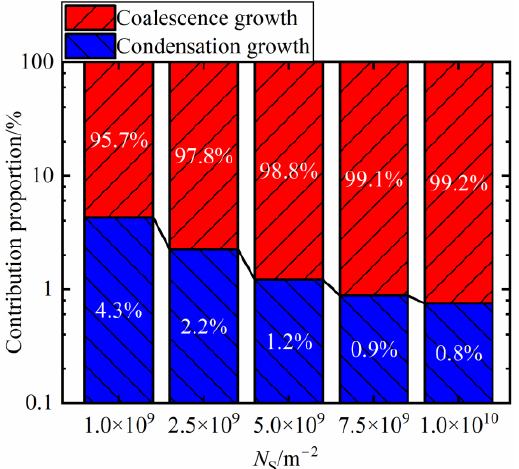
Figure 15. Change of contribution proportion of two growth modes to the maximum droplet size under different nucleus densities.